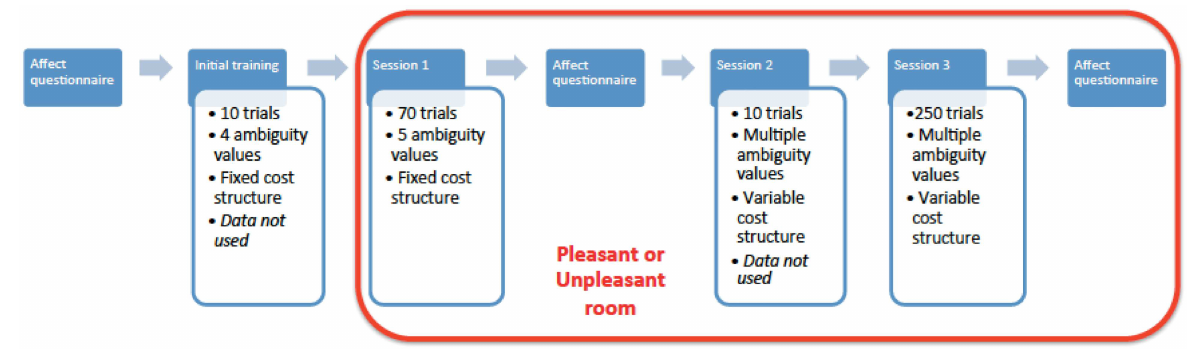
Fig 2. Schematic of the experimental procedure. The order in which affect questionnaires and the different phases of task training and testing were carried out is shown, together with basic information on the trial structure of each session. Phases within the red box took place in either the Pleasant or Unpleasantroom. See text for more